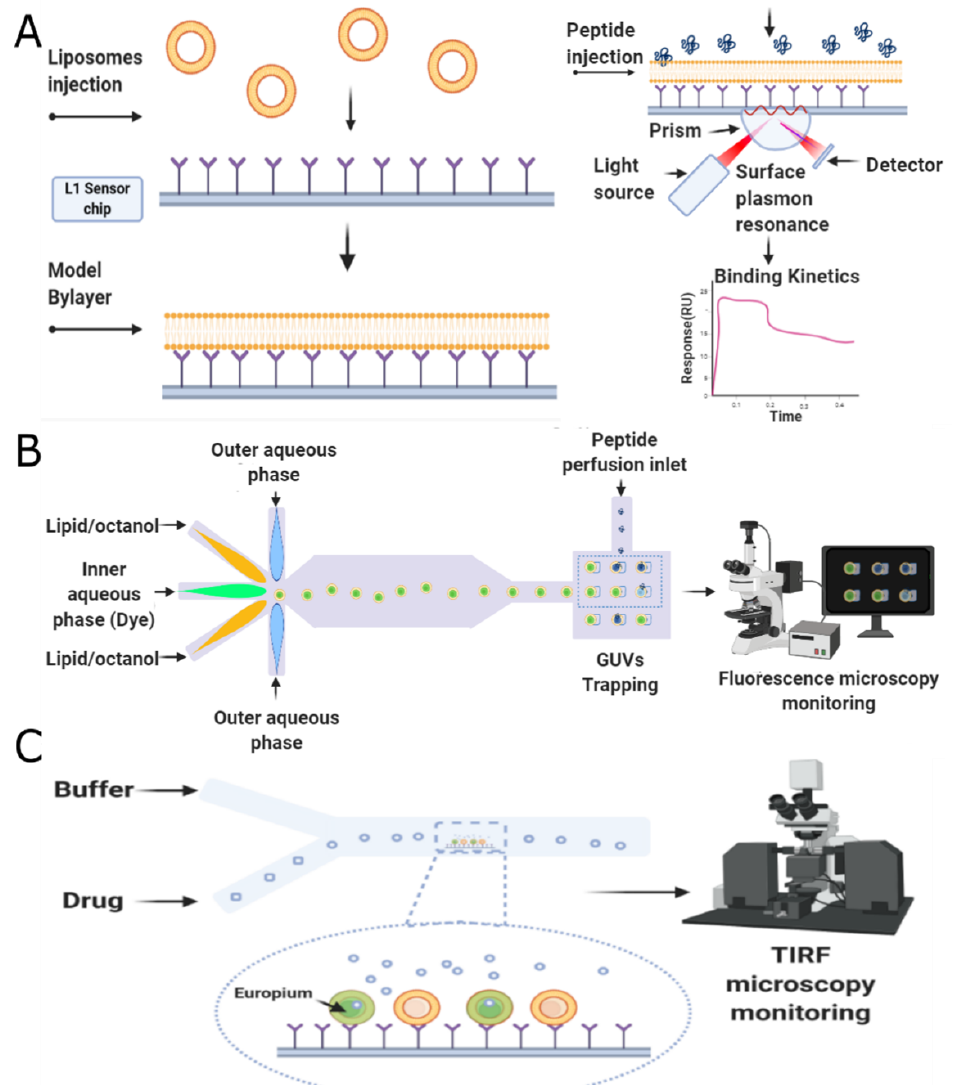
Figure 8. Membrane-based approaches for bioactive compounds screening. ( A ). Surface plasmon resonance (SPR) interaction analysis carried out by Hall et al. and Šakanovič et al. where a lipid planar bilayer is generated in the surface of a sensor chip in which the peptide membrane interactions are measured by surface plasmon resonance [231,232]; ( B ). Membrane-based screening using giant unilamellar vesicles (GUVs) as described by Nahas et al. where GUVs are generated by the octanol-assisted liposomes assembly method (OLA) technique and immobilized in a chamber where the peptides are injected in order to analyze the membranolytic activity by the leak of a dye previously encapsulated into the GUVs lumen.( C ) Vesicle screening platform used by Kuhn where the GUVs are immobilized onto a glass-bottom and a delivery of the tetracycline is carried out to analyze the drug permeation using a total internal reflection fluorescence (TIRF) microscopy due to the red fluorescence complex generated by Europium-tetracycline binding.(Created with BioRender). Al Nahas et al. presented a novel microfluidic platform for the characterization of membrane- active antimicrobials (see Figure 8B). The platform adapted the OLA method for the high-throughput